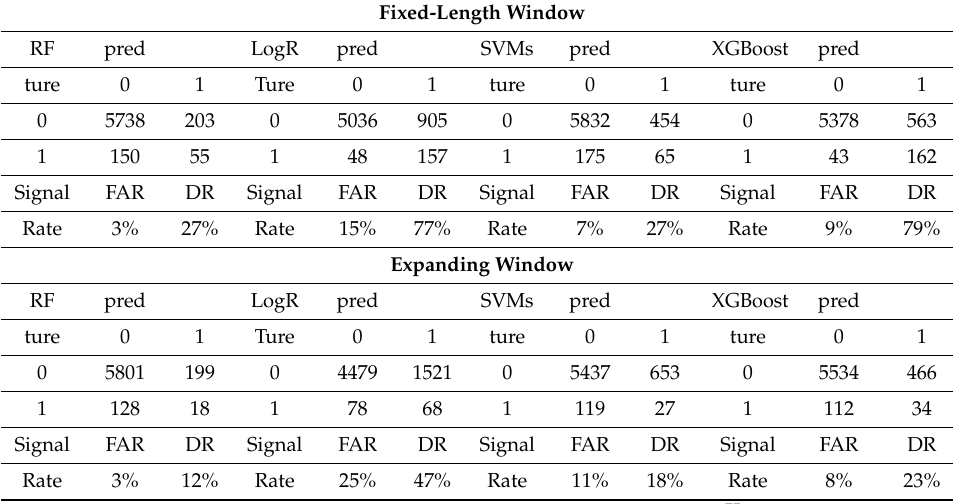
Table 6. Classification accuracy table for Dataset1.